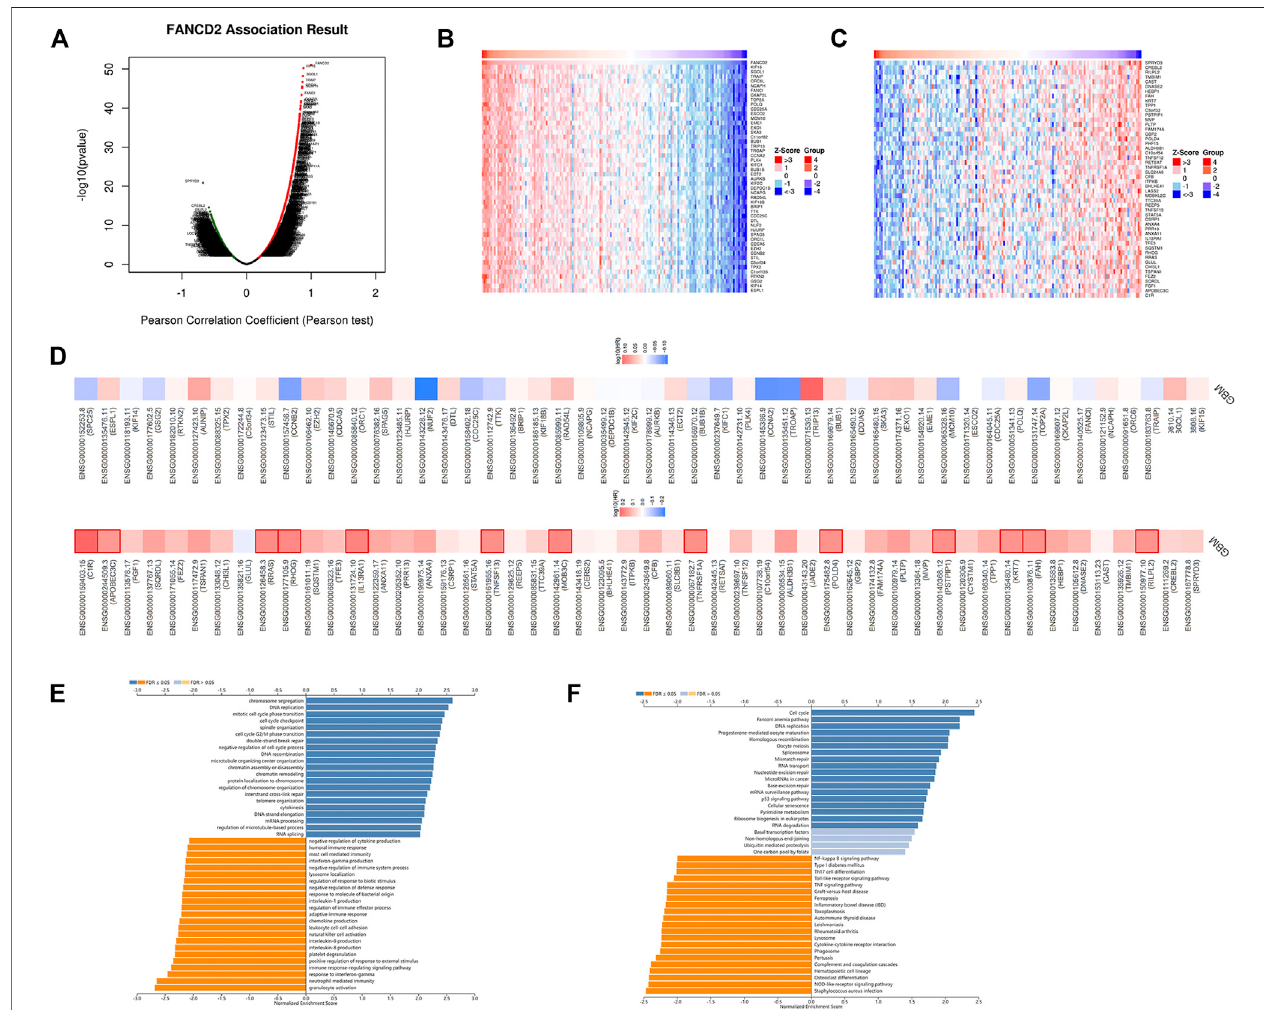
FIGURE 5 | The co-expression genes of FANCD2 in GBM (A) LinkedOmics database indicated the signi fi cantly correlated genes with FANCD2 in GBM (B – C) Heatmaps indicated the top 50 genes displaying positive and negative associations with FANCD2 in GBM (D) Survival heatmaps exhibited the prognostic values of the top 50 genes displaying positive and negative association with FANCD2 in GBM (E – F) GO and KEGG annotations of FANCD2 co-expression genes in GBM.